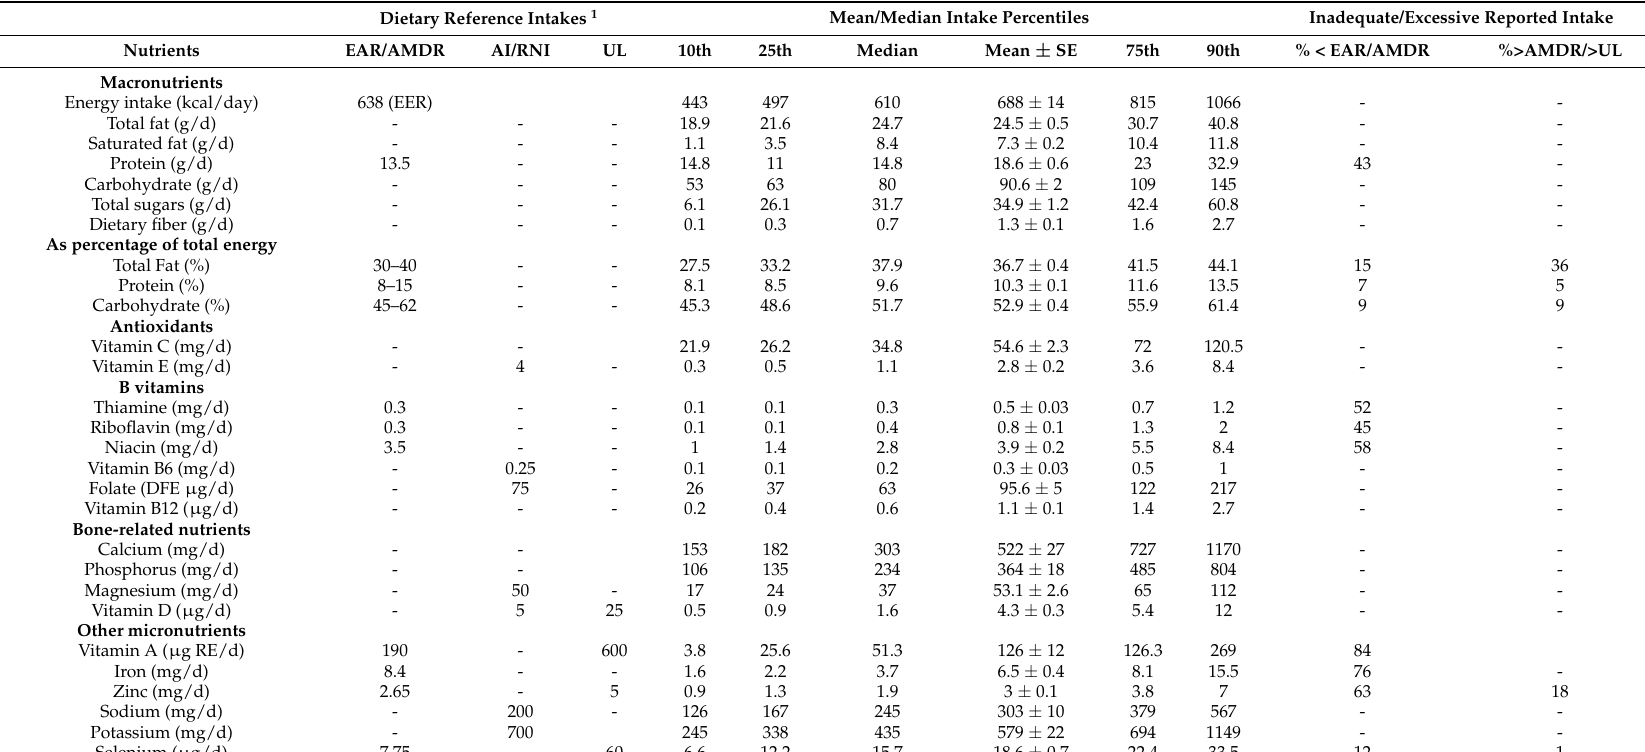
Table 3. Usual energy and nutrient intakes from food and beverages for Filipino infants aged 6–11.9 months ( n =